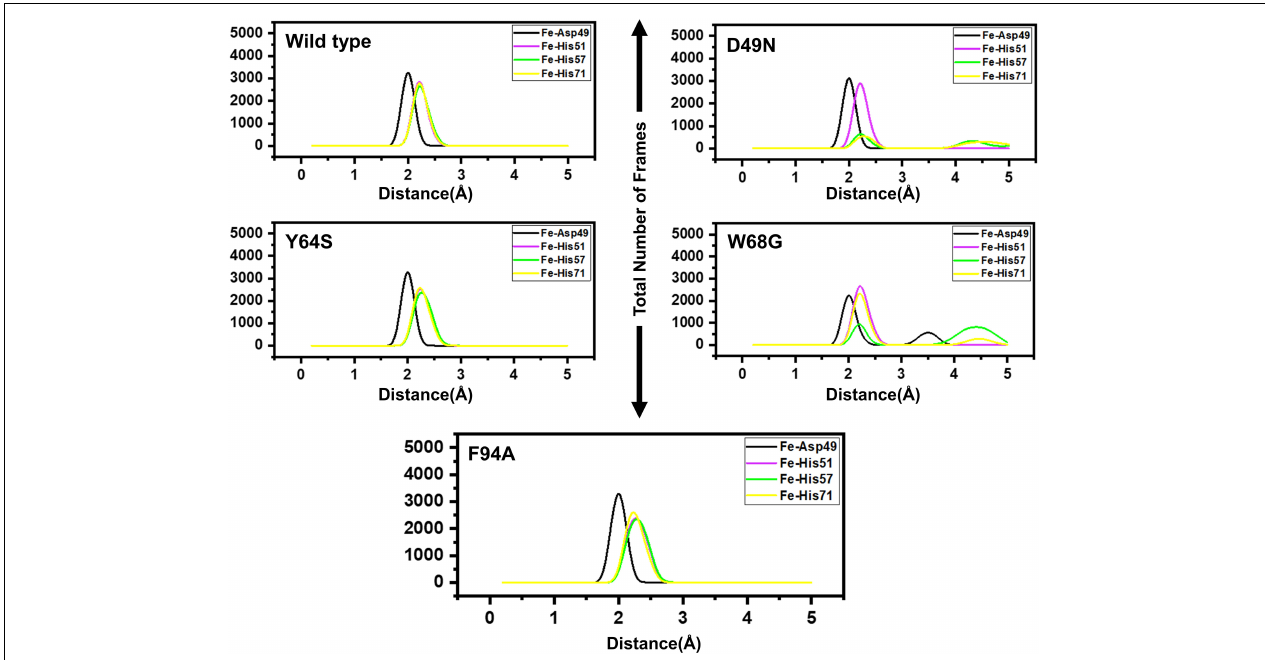
FIGURE 4 | Distances between the Fe 2 + ion and its coordinating four residues. Furthermore, within each figure inside, there is a legend that shows the distance between Asp49 [O], His51[N], His57[N], His71[N] and Fe 2 + ion. Each residue from the metal coordinates is differently colored.